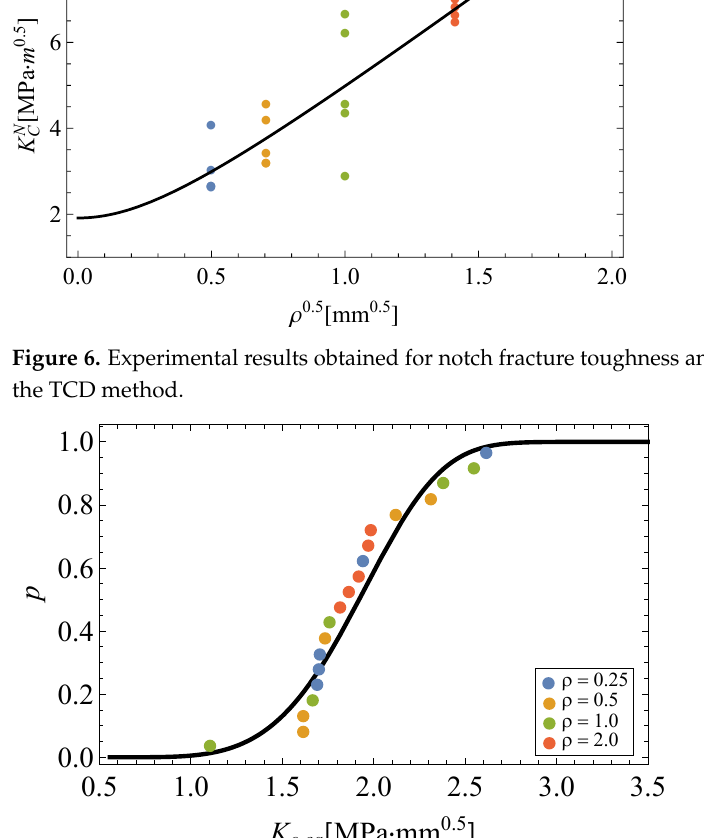
as a function of the notch radius for a given P fail of